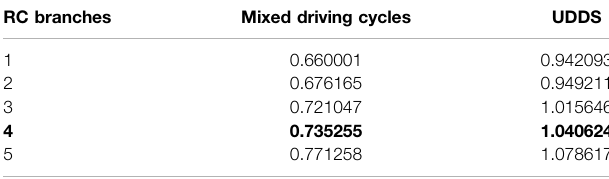
TABLE 18 | Time consumption of the augmented ECM-based